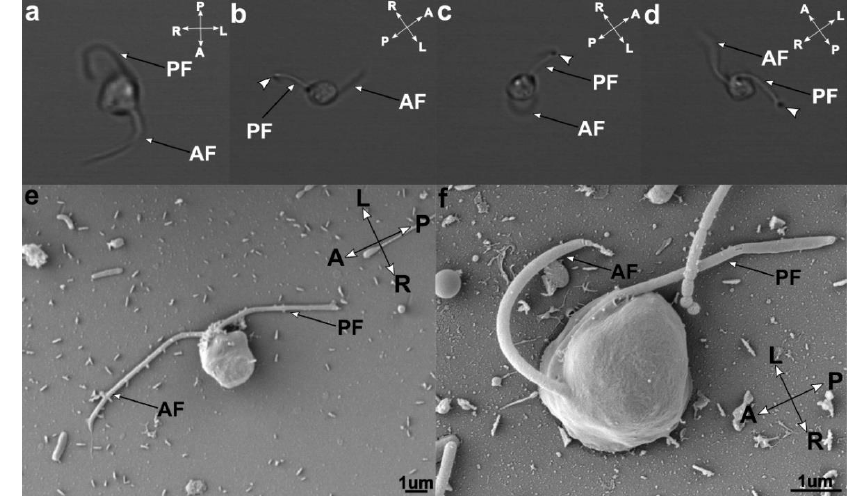
Figure 1. Cell appearance as observed using light microscopy ( a , b , c , d ) and scanning electron microscopy (SEM) ( e , f ). Light microscopy pictures show the attachment of the posterior flagellae (PF) to the surface (arrow) and the movement of the anterior flagellum (AF). SEM pictures ( e , f ) of Cafileria marina capturing the smooth surface of the cell wall and flagellae positions. The cell orientation was established arbitrarily by declaring the swimming direction to be forward and as follows: A: anterior, P: posterior, L: left, and R: